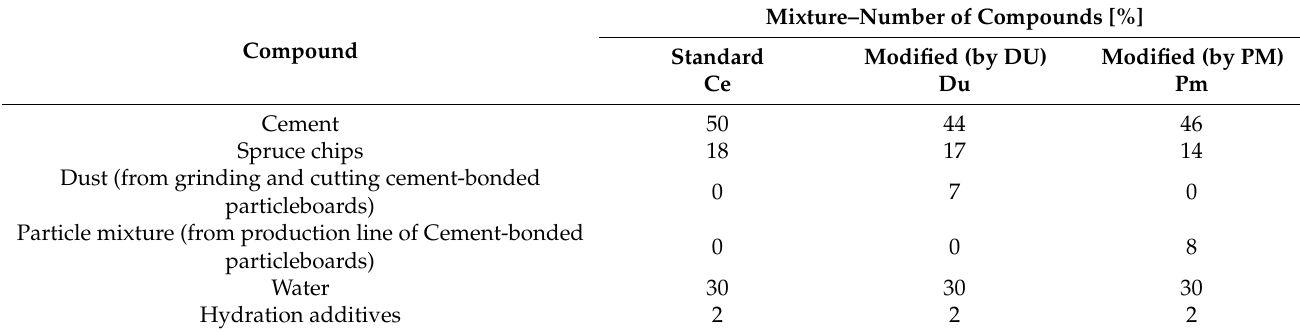
Table 1. Composition of cement-bonded particleboards–standard and modified mixtures.